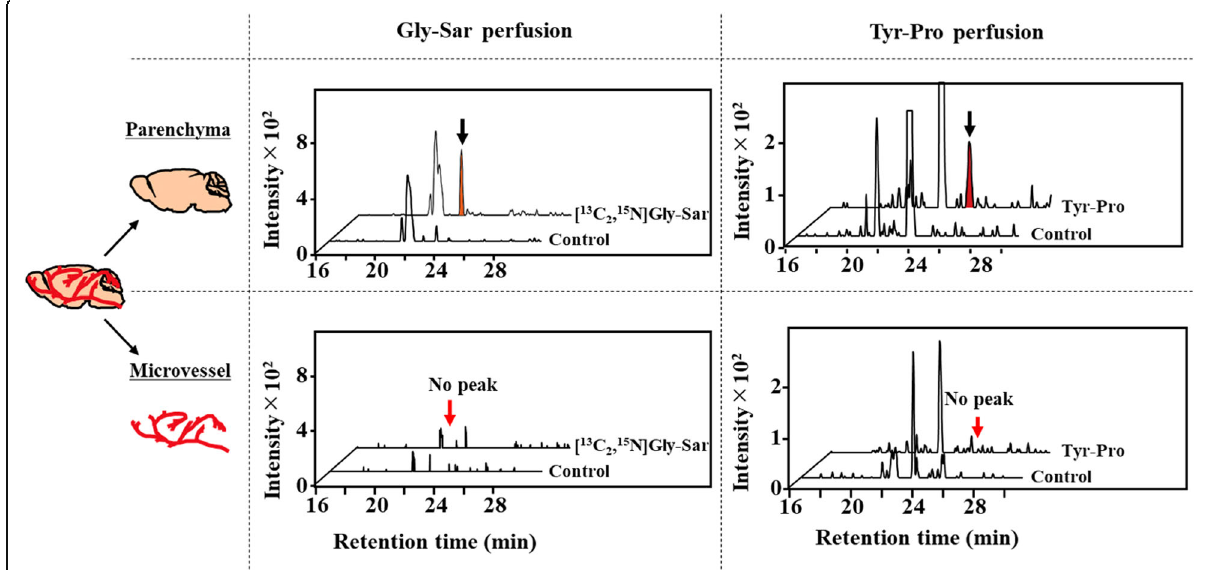
Fig. 3 Transport of dipeptides, Gly-Sar and Tyr-Pro, into the parenchyma of 2.0-min perfused mouse brain. [ 13 C 2 , 15 N]Gly-Sar and Tyr-Pro in the parenchyma and microvessel fractions of mouse brain were detected by